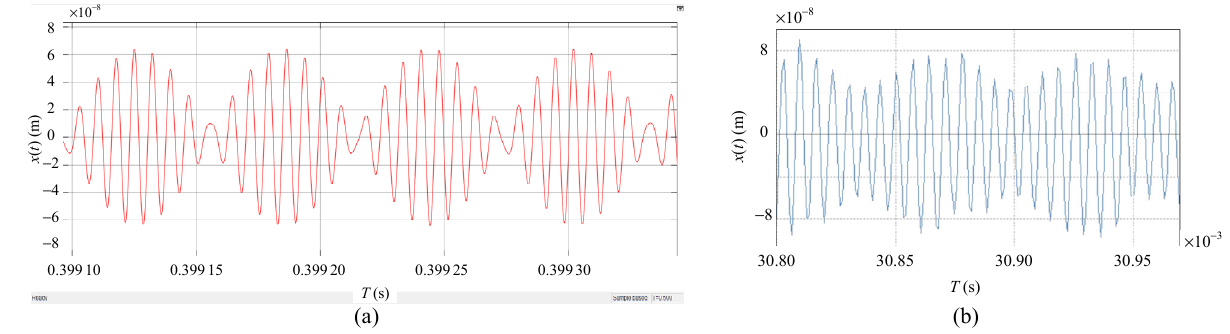
Fig. 5 “Beat” generated by applying the sinusoidal Coulomb force: (a) simulation and (b) experimental